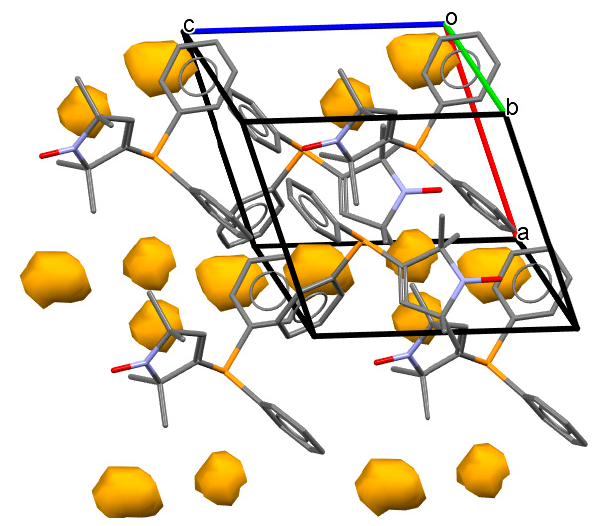
Figure 3. Packing diagram of 8 . Hydrogen atoms are omitted for clarity.